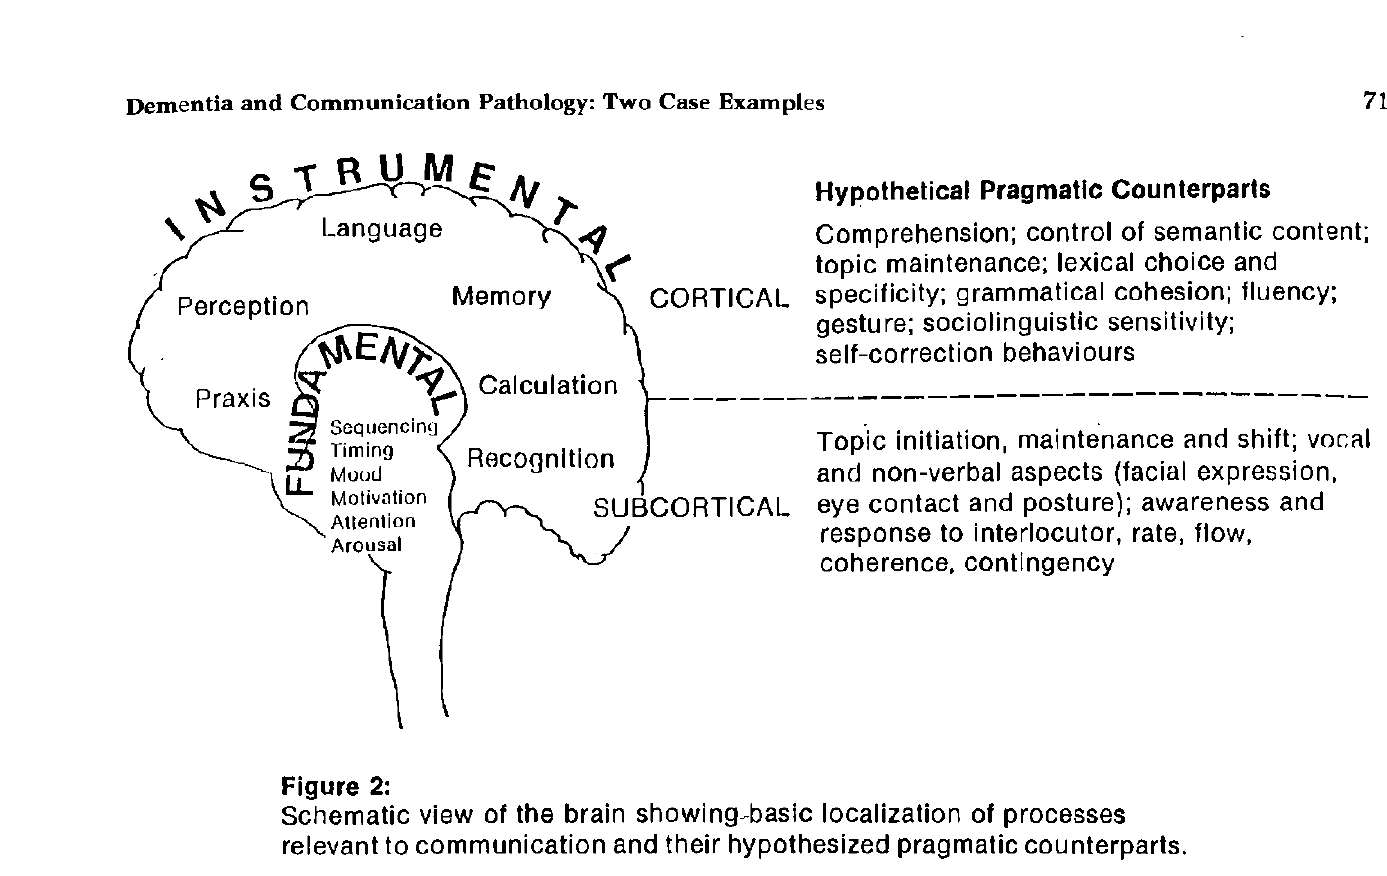
Schematic view of the brain showing-basic localization of processes relevant to communication and their hypothesized pragmatic